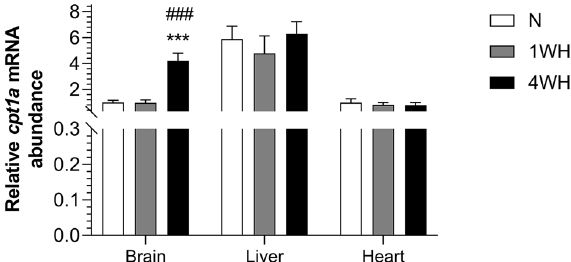
Figure 7. Relative transcript abundance of cpt1a , whose protein product is involved in the mitochondrial β-oxidation pathway, in tissues of normoxic controls (N), 1-week hypoxic (1WH) and 4-week hypoxic (4WH) goldfish. Values are means ± standard error of the mean (s.e.m.); sample size = 7–12 per group. Differences between normoxia and chronic hypoxia are indicated as ***( p < 0.001). Differences between 1 and 4WH are indicated as ###( p <